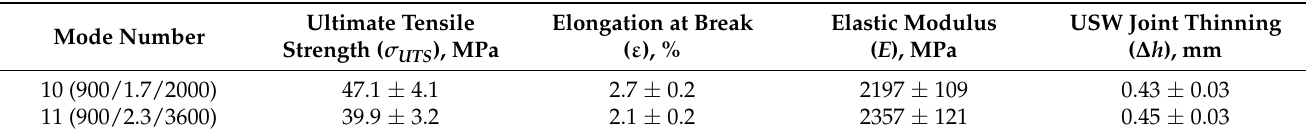
Table 6. The mechanical and dimensional characteristics of the USW lap joints obtained with the parameters optimized by ANN simulation.